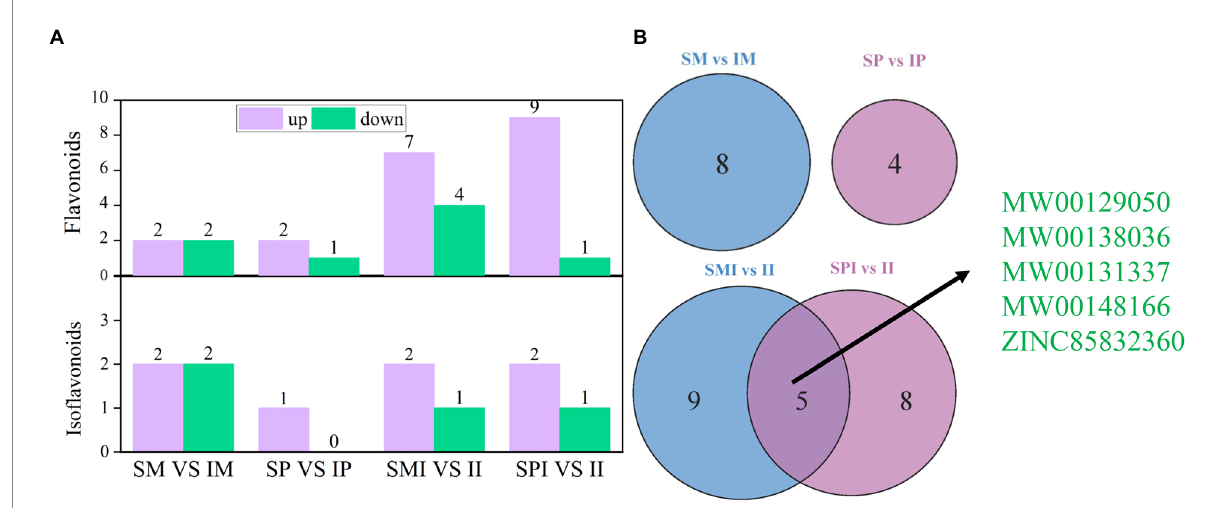
FIGURE 4 Distribution of flavonoids and isoflavonoids in rhizosphere soils of maize and peanut in different planting patterns. (A) The number of flavonoids and isoflavonoids. (B) Venn diagram of different planting patterns. SM: sole maize, IM: intercropped maize, SP: sole peanut, IP: intercropped peanut, SMI: the shared soil of sole maize, SPI: the shared soil of sole peanut, II: the shared soil of intercropped maize and peanut.